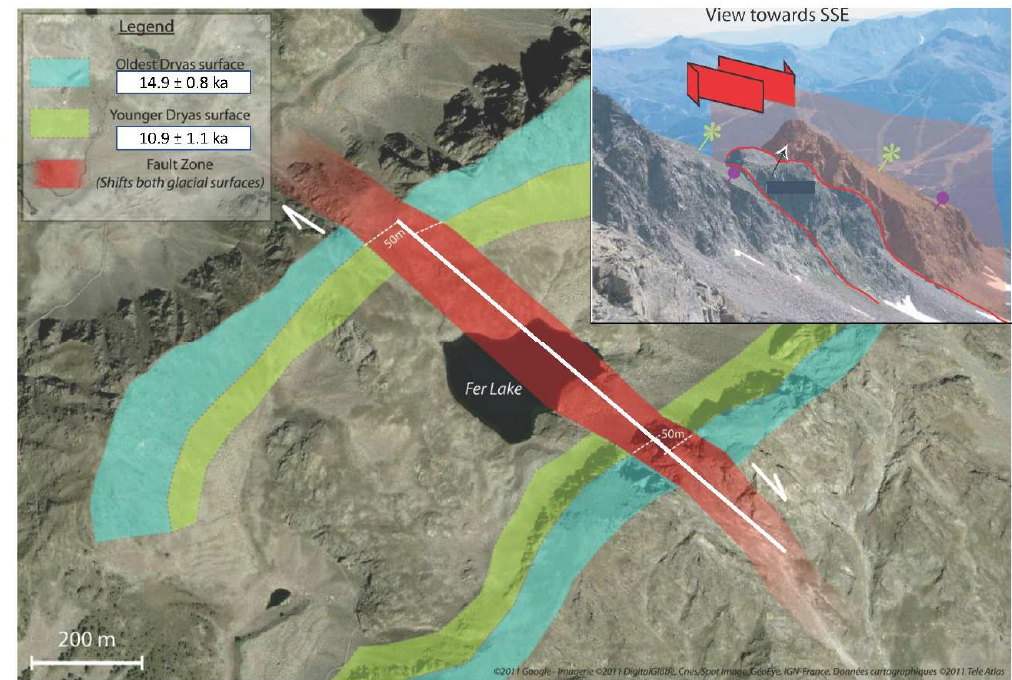
Figure 4. Glacial offset geomorphologies in the Argentera crystalline massif from [27,52]. Polished surfaces were dated with quartz 10 Be CRE dating. Green stars in insert landscape photo locate the position of the upper, more gently dipping Oldest Dryas surface, while the purple circles locate the break in slope related to incision of the Younger